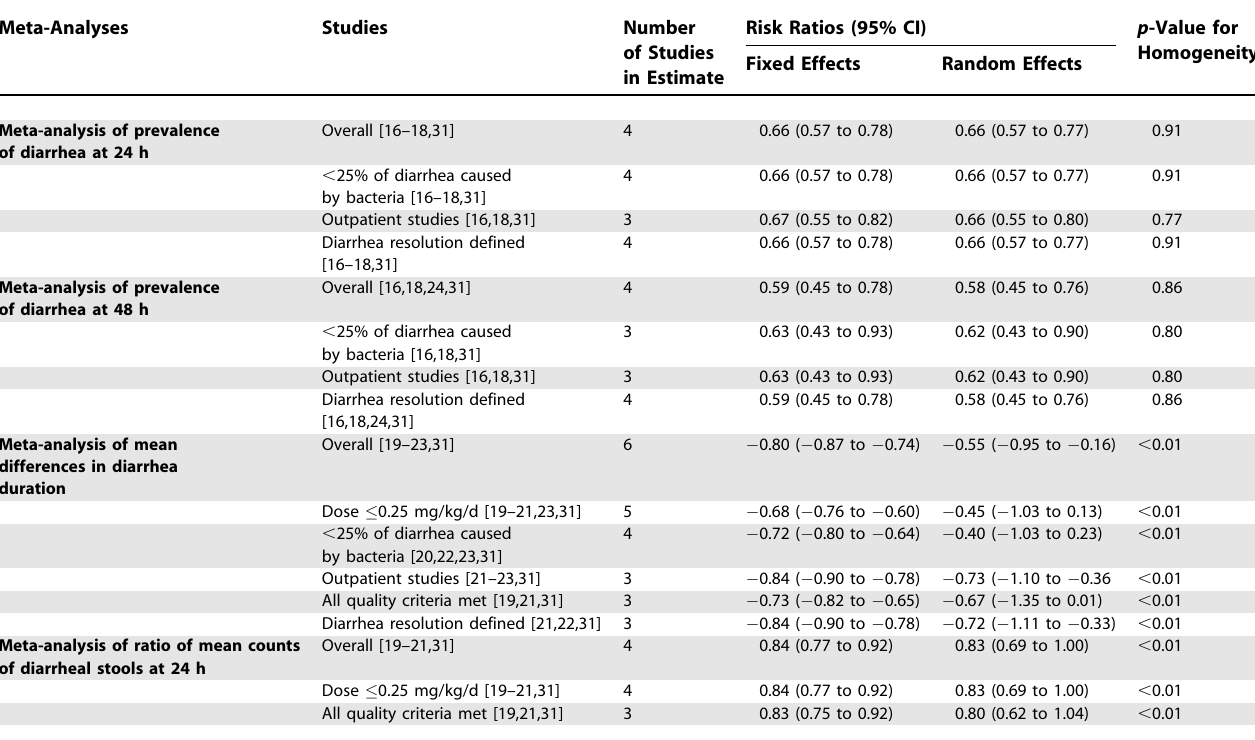
Table 4. Meta-Analysis Results among Those on Loperamide Compared with